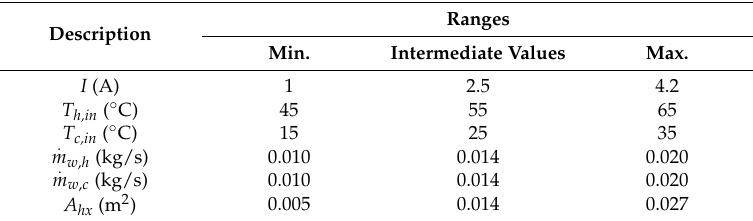
Table 2. Operating parameters and